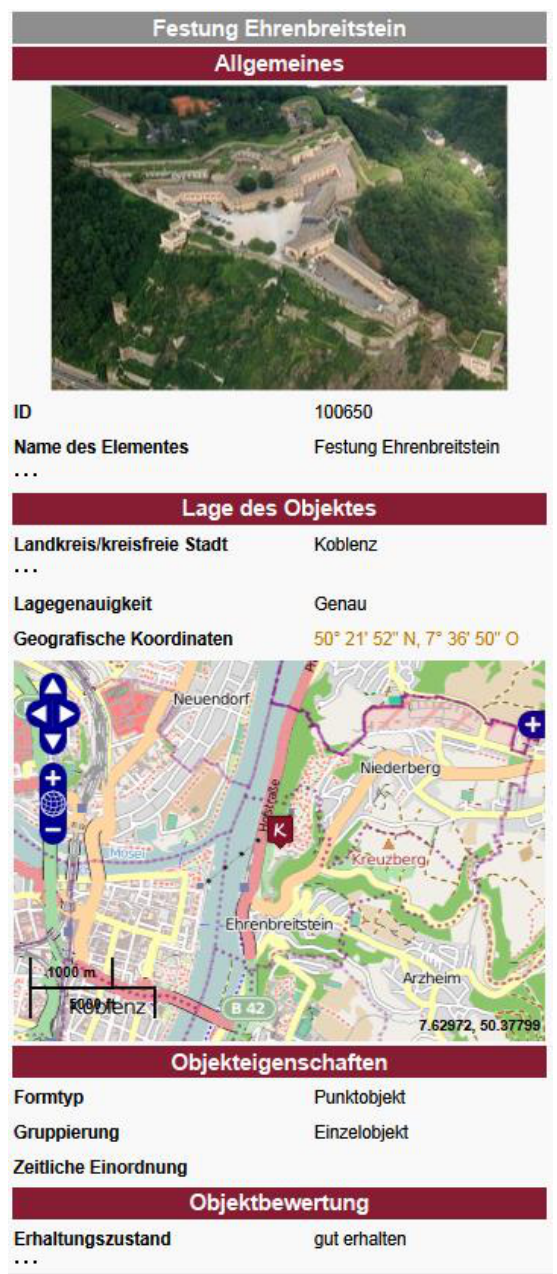
Figure 3. Profile of Ehrenbreitstein